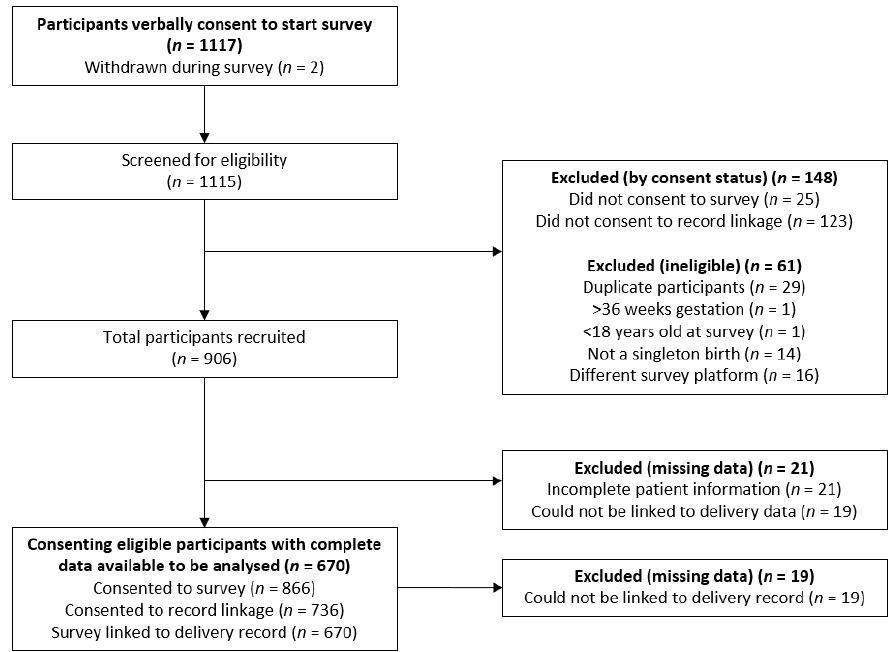
Figure 1. Strengthening the Reporting of Observational Studies in Epidemiology (STROBE) flow diagram of participant inclusion and